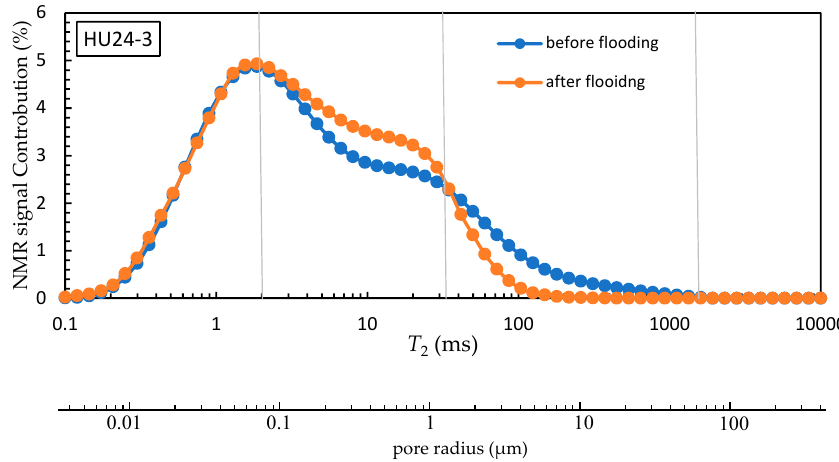
Figure 8. NMR T 2 spectrum of the core HU24-2 before and after the CO 2 -WAG flooding and the core HU24-3 before and after the CO 2 flooding. Table 7. Changes of pore size distribution in the cores HU24-2, HU24-3 after flooding.